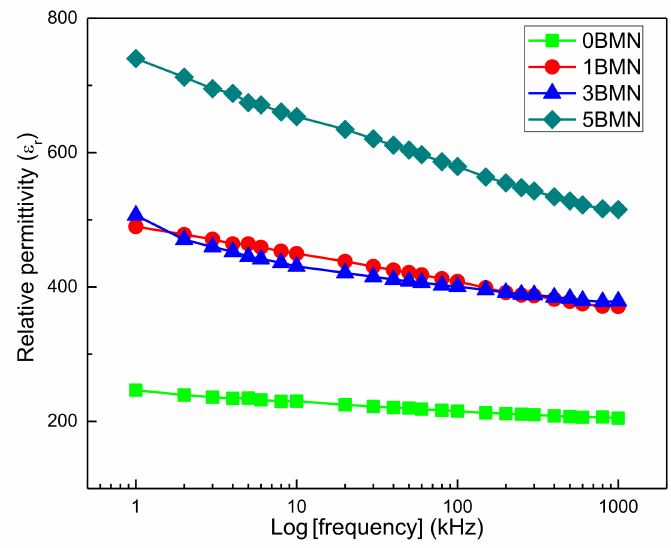
Figure 5. Frequency dependence of relative permittivity ( ε r